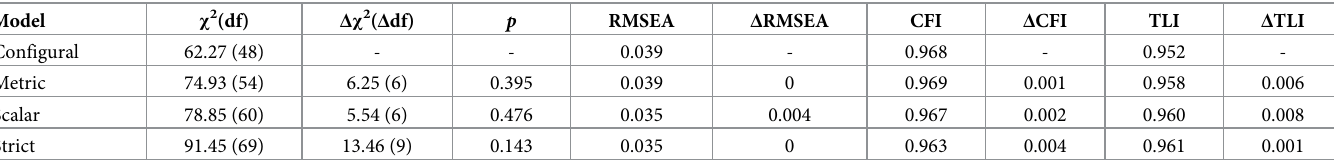
Table 4. Measurement invariance across